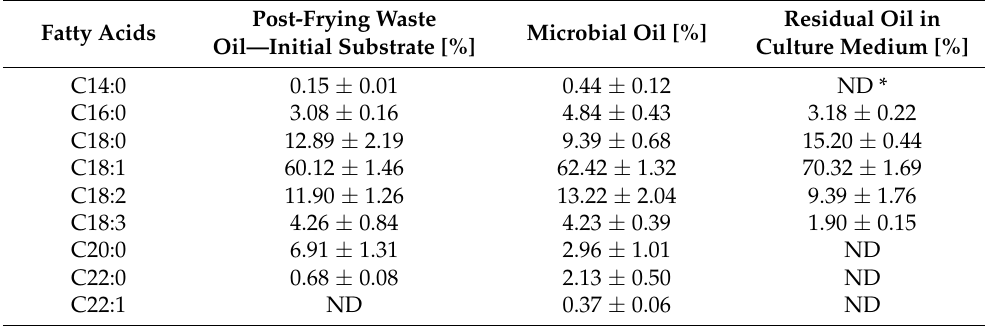
Table 4. Comparison of fatty acid content in lipids synthesized in cells during Y. lipolytica